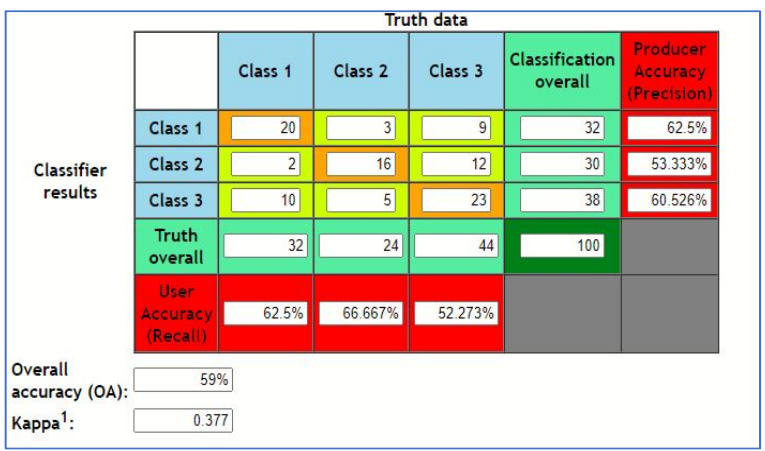
Figure 6. SVM Performance. The accuracy of SVM (linear) is 59% as shown in the truth table (Fig- ure 6).